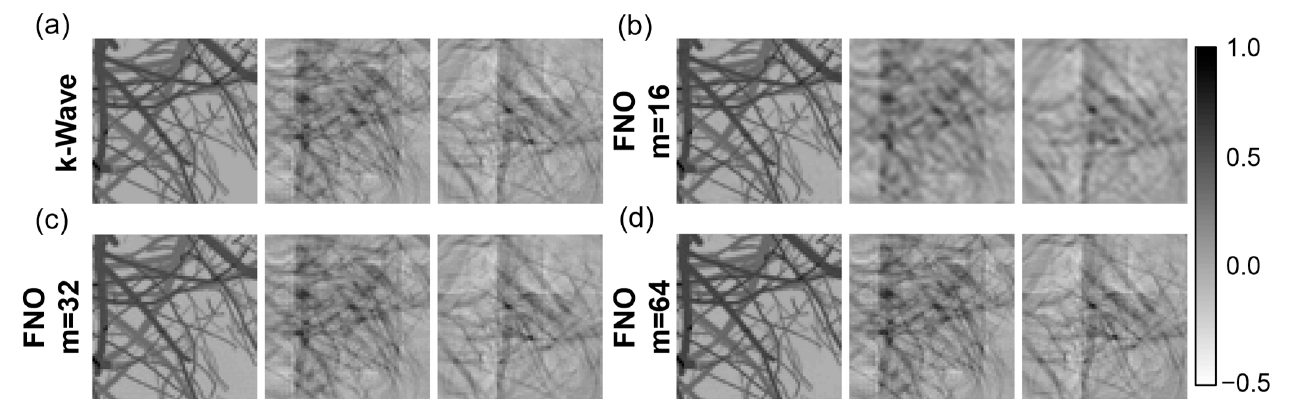
Figure 7. Comparison of FNO simulations at t = 1, 5, 10, 15 and 20 time steps. (a) k-Wave simulation. (b) The FNO network were parametrized with channels = 5 and modes = 16. (c) The FNO network were parametrized with channels = 5 and modes = 32. (d) The FNO network were parametrized with channels = 5 and modes = 64. Table 1. Comparison of FNO network hyperparameters. Grid